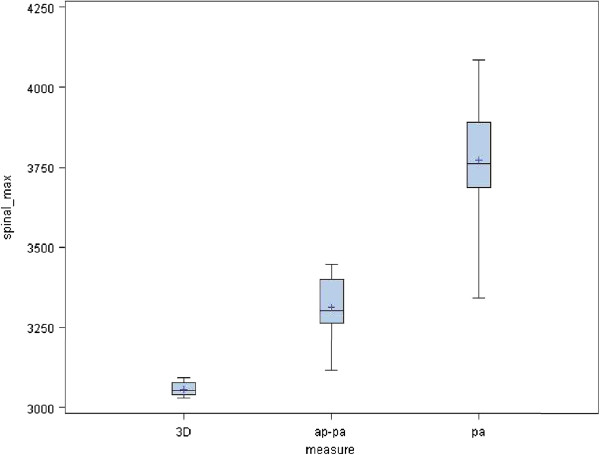
Maximal dose to the spinal cord. These histograms show that the lowest maximal spinal cord dose is achievable with the 3D conformal plan.